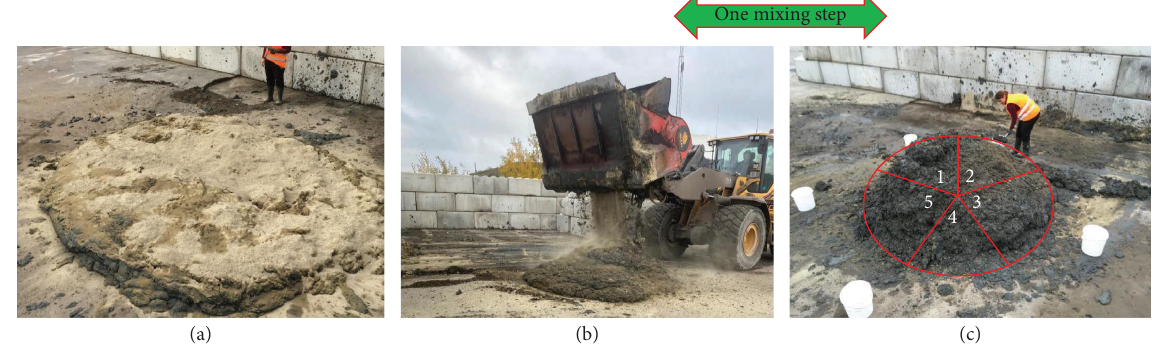
Figure 3: Mixing procedure in the feld. (a) Spreading binder. (b) Blending by mixer. (c) Section sampling.